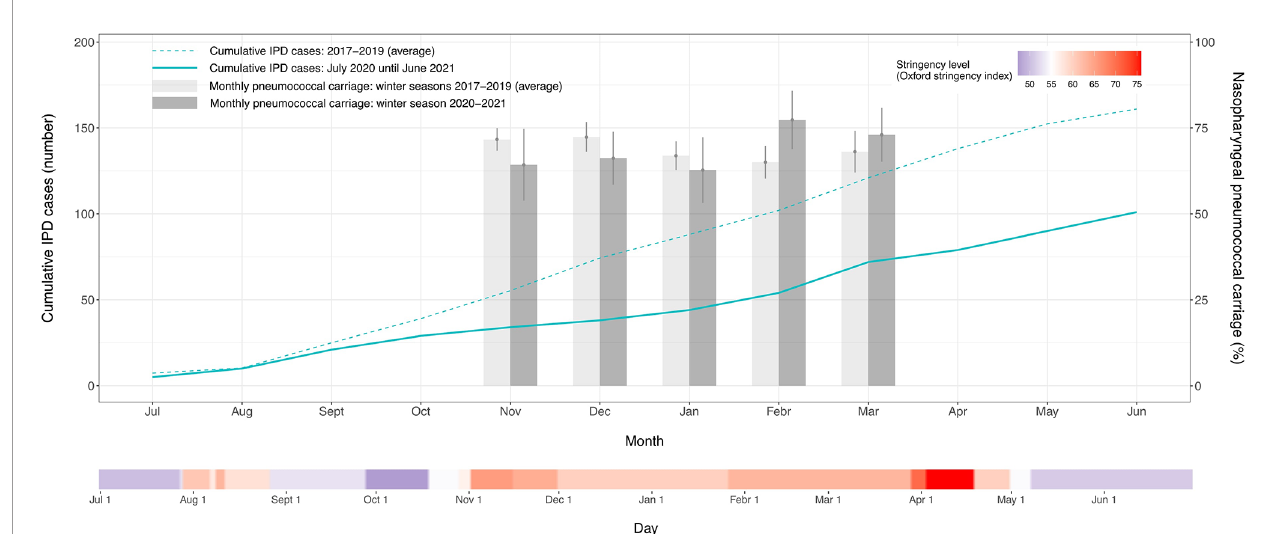
FIGURE 1 | Streptococcus pneumoniae carriage rates and invasive pneumococcal disease cases in young children (aged <3 years) obtained from July 2020 until June 2021 and compared to the previous three epidemiologic years. The cumulative number of invasive pneumococcal disease cases and the average pneumococcal carriage prevalence are respectively shown as a monthly total and a monthly percent proportion. The vertical lines on the bars represent the 95% con fi dence intervals of the monthly percent carriage proportions. The time point indicated on the x-axis represents the middle of each month. A second continuous axis shows the daily level of stringency of the COVID-19 containment measures implemented in Belgium from July 2020 until June 2021. The stringency index is based on the Oxford COVID-19 Government Response Tracker and is shown on a gradient color scale going from 0 to 100, with red values indicating that higher stringency measures were